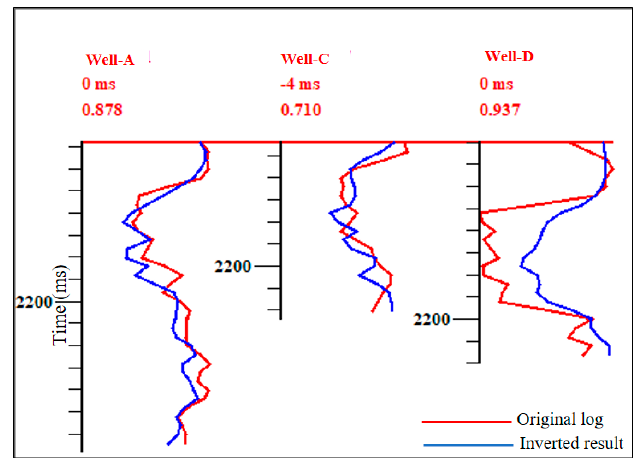
Figure 12. The inverted AI for Xline 932 using SVM seismic inversion. The impedance log of well-A, C, and D are not in good match with the inverted impedance surface.